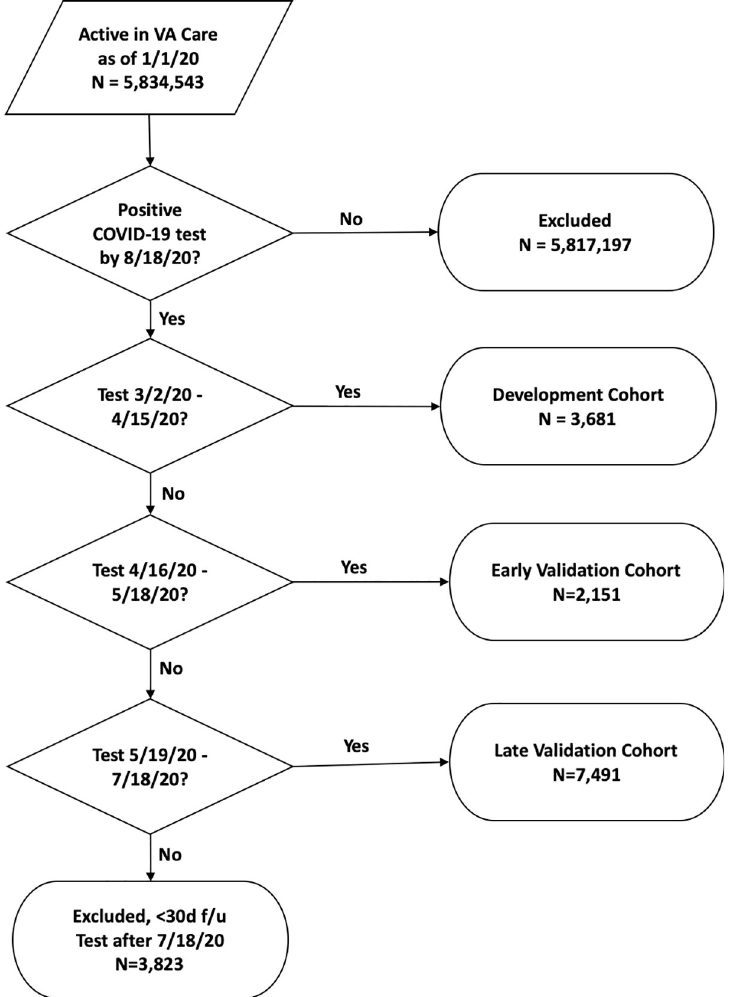
Fig 1. Flow diagram of VACO Index cohort selection. Flow diagram showing selection of VACO Index cohorts from 5,834,543 patients active in VA care as of January 1, 2020. All COVID-19 tests were performed in the VA. Patients with COVID-19 tests after July 18, 2020 did not have 30 days of follow-up and were excluded from the